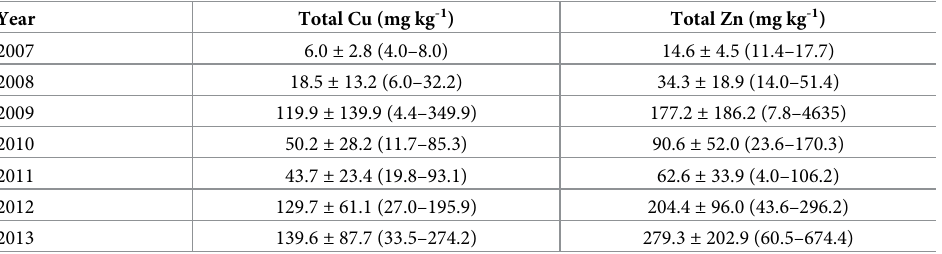
Table 1. Concentration of Cu and Zn in the surface sediment averaged by year, data presented as mean concentration ± standard deviation and (minimum—maximum) concentrations (mg kg -1 dry